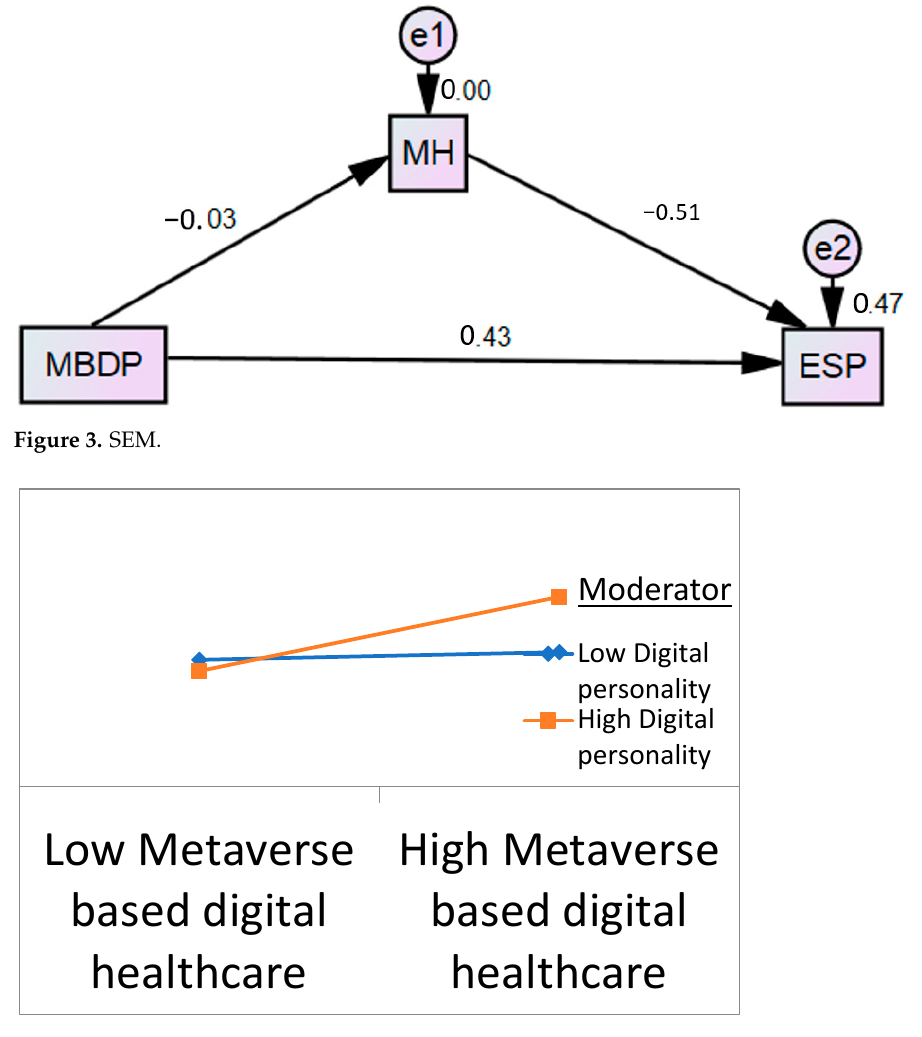
Figure 4. Graphical representation of the moderation hypothesis.